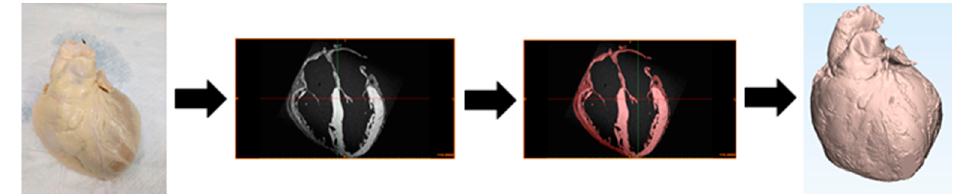
Figure 1. (Left to right) 3D model generation pipeline starting with profusion-fixed human heart, cardiac MRI scan, 2D segmentation mask of the cardiac myocardium, and resulting 3D model of the heart.